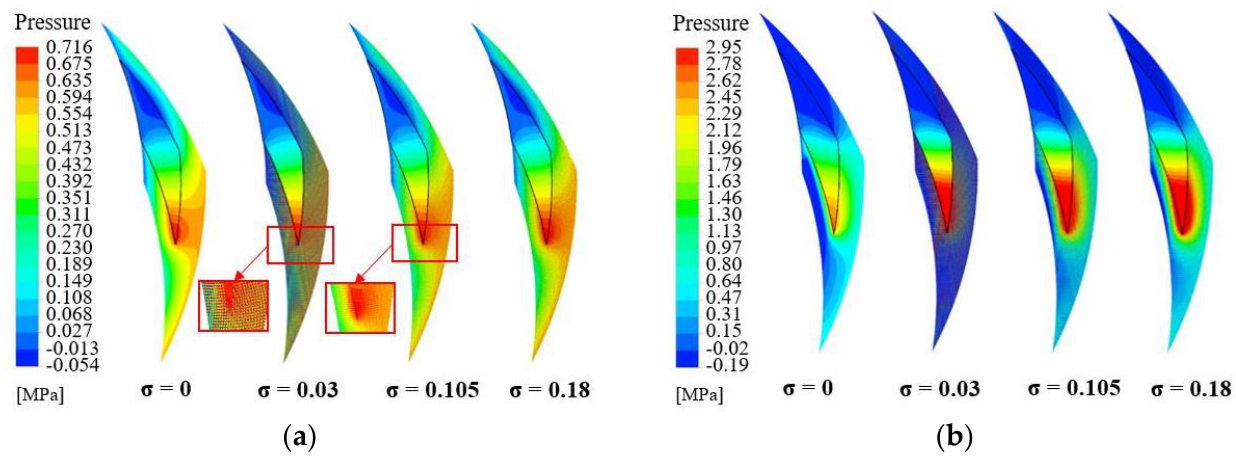
Figure 13. Pressure distribution under different roughness levels in the non-grooved zone of the rotating ring: ( a ) n = 1000 rpm, ( b ) n = 10,000 rpm.